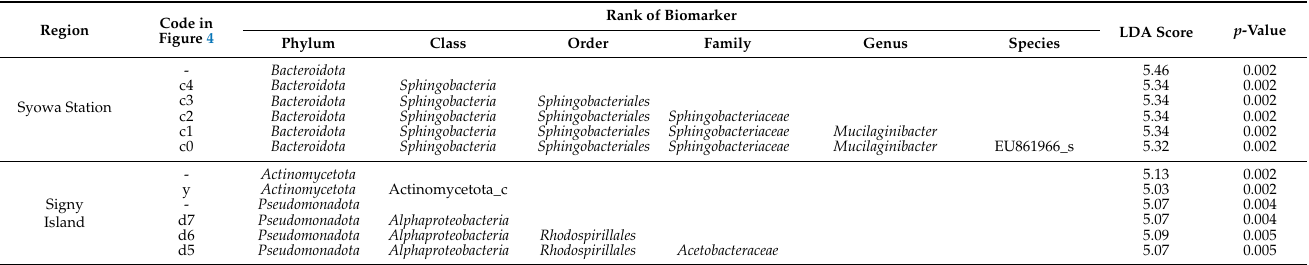
Figure 5. Significant differences ( p < 0.05) in relative abundances of the top biomarker OTUs from the Syowa Station region (red) and Signy Island (green) analyzed by ANCOM-BC. ( Left ), the most significant biomarker from Signy Island, FM874383_s, affiliated with the genus Gluconacetobacter . ( Right ), the most significant biomarker in the Syowa Station region, EU861966_s, affiliated with the genus Mucilaginibacter . Other significant biomarker OTUs are shown in Figure S8. Table 6. Biomarker OTUs and taxa having LDA scores >5 identified from the assigned OTU diversity obtained in the Syowa Station region and from Signy